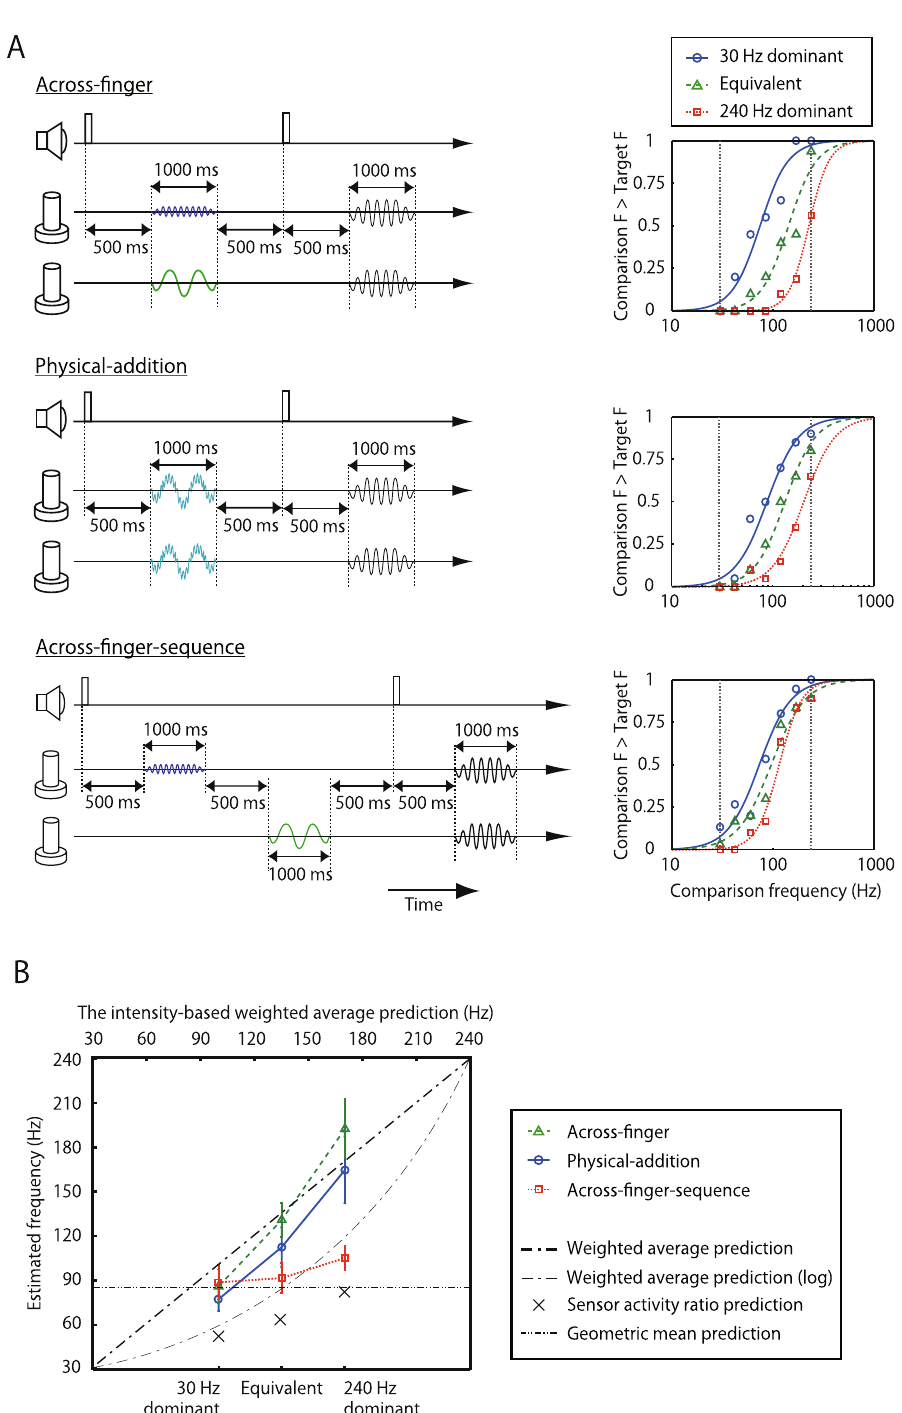
Figure 4. Frequency interpolation between low- and high-frequency vibrations. ( A ) Trial sequence and typical example of the individual data. The target pair and the comparison pair were sequentially presented on two fingers. Participants were asked to make binary responses (higher, lower) about the perceived vibration frequency of the second pair compared to the first. In this experiment, participants were not informed of any possible differences between paired vibrations, and they did not receive any feedback signal after their response. For the target pair, the amplitude of the 30-Hz vibration was fixed, while that of 240-Hz vibration was varied (0.5, 1, or 2 relative to 30- Hz intensity, each called 30 Hz dominant, Equivalent, 240 Hz dominant) to evaluate the perceived frequency shift. The order of target and comparison pair was randomized in Across-finger and Physical-addition conditions. The finger on which the 30- or 240-Hz vibration was presented as a test pair was randomized in Across-finger and Across-finger-sequence conditions. ( B ) Experimental results and theoretical values. Green triangles with a dashed line represent averaged PSEs of the target pair of the Across-finger condition from 11 participants, blue circles with solid line represent that of Physical-addition condition